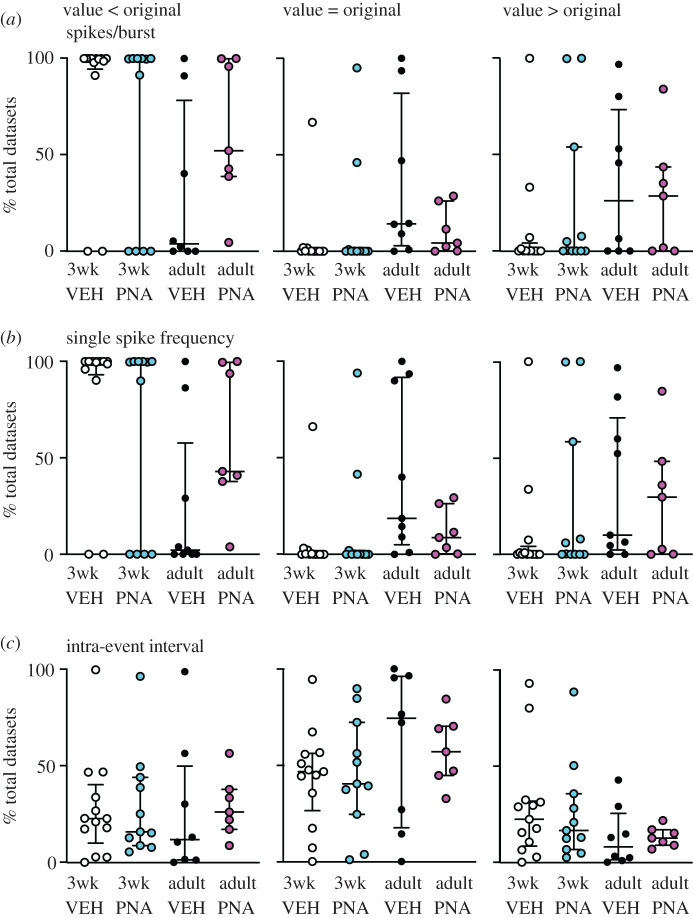
Comparison of original data to total datasets for selected burst parameters. Each dot shows the percentage of total datasets from an individual cell that is less than (left), equal to (centre) or greater than (right) the original data's value for the indicated parameter for a burst window of 360 ms. (a) spikes/burst; (b) single-spike frequency; (c) Intra-event interval. Graphs show individual values, median and interquartile range.